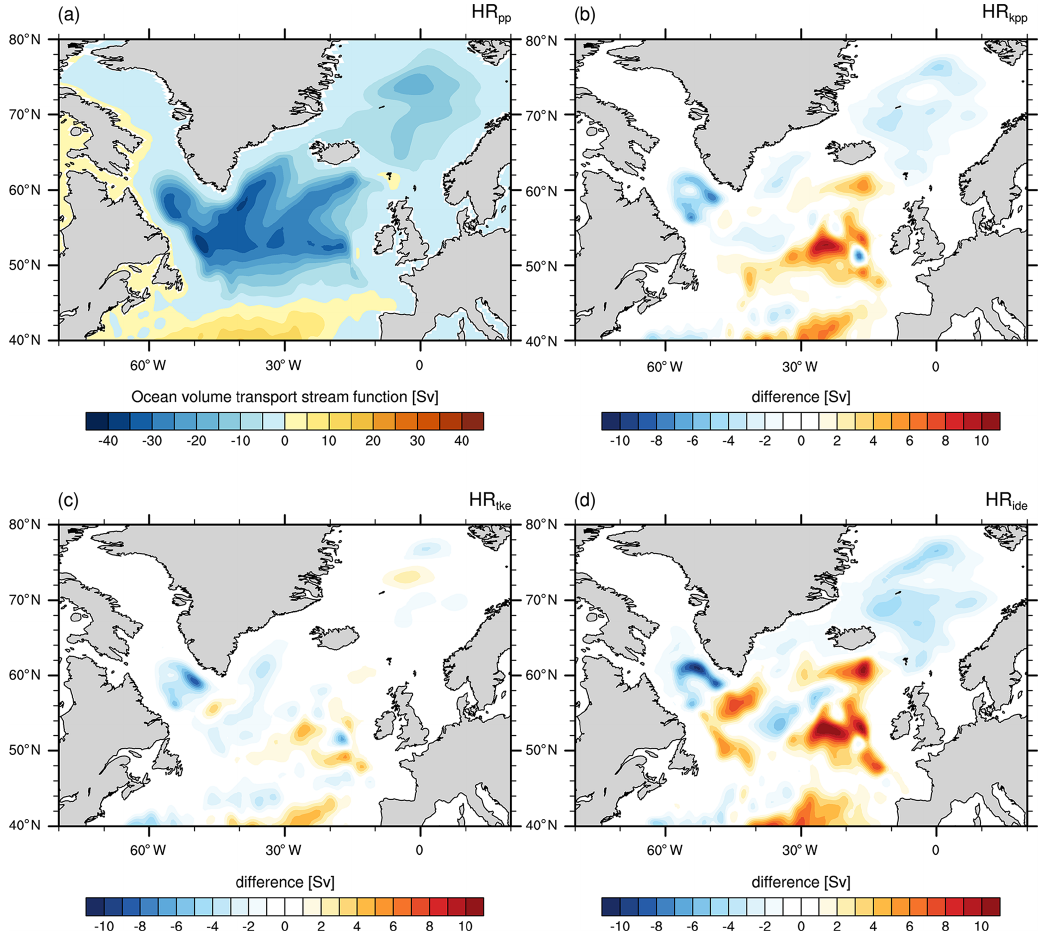
Figure 13. Time-averaged barotropic volume transport stream function (Sv) in the North Atlantic as simulated by MPI-ESM1.2 (a) HR pp , and the differences of “experiment – HR pp ” for (b) HR kpp , (c) HR tke , and (d) HR ide .